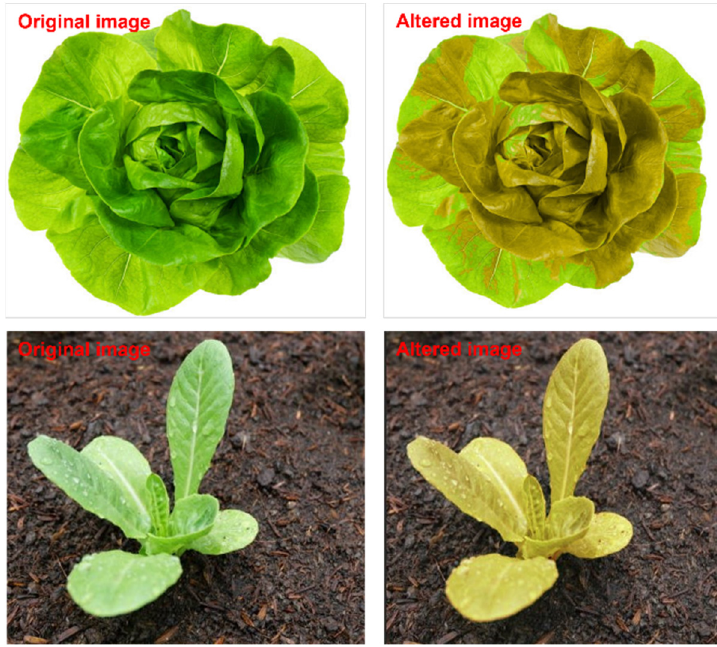
Figure 6. Example of images generated in Adobe Photoshop (left original images, right for the altered images).